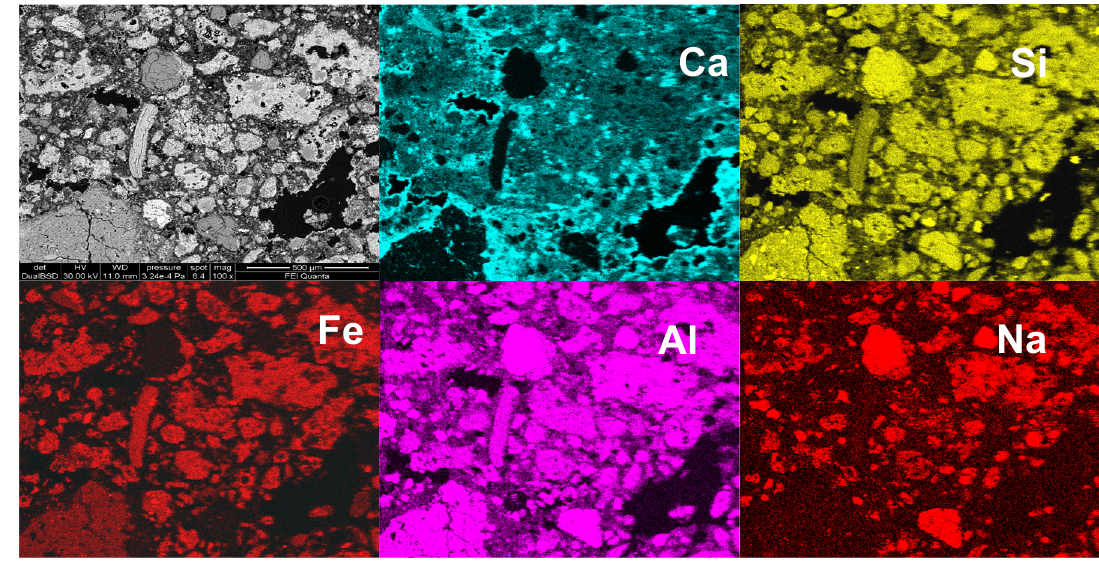
Figure 10. BSE image and X-Ray maps of the sample M2.